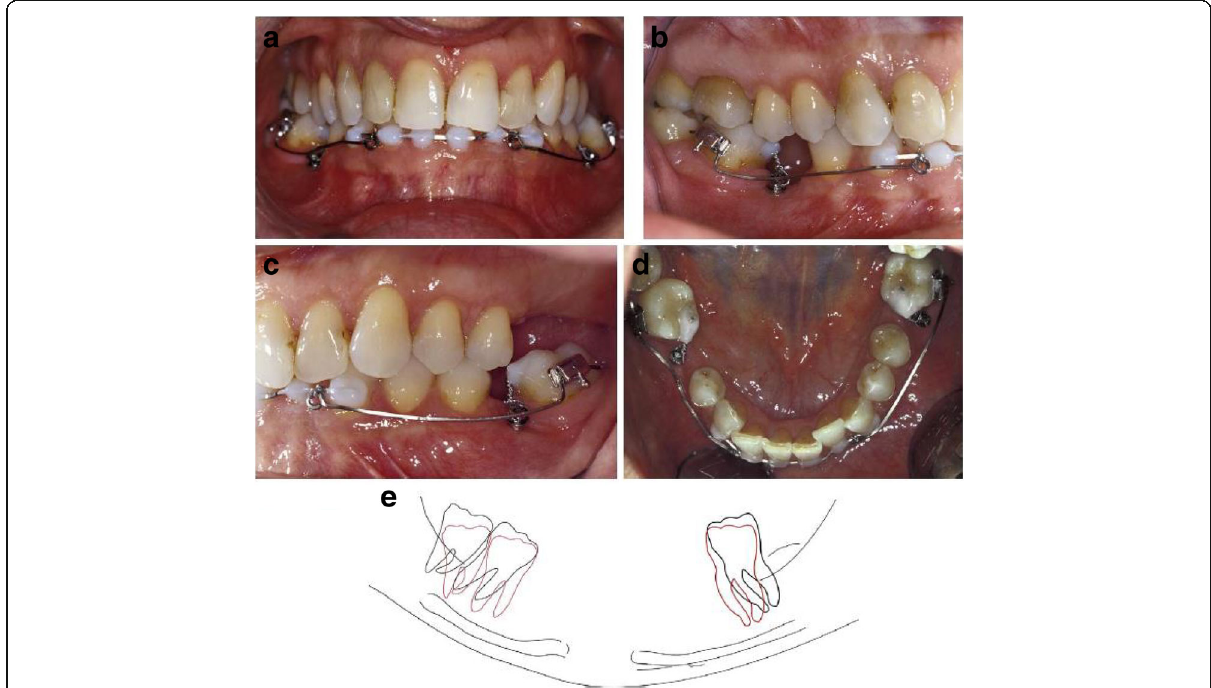
Fig. 11 Uprighting of mesially tipped #37 and #46 with miniscrew implant and long cantilevers. The cantilevers generate molar uprighting, molar extrusion, and intrusion of the anterior teeth. Ligature between miniscrew and molar is used to control the extrusive force and the distal crown movement of each molar. Thus, the uprighting is mainly achieved by mesial root tipping. a The beginning of uprighting of #37 and #46 with long cantilevers, from the molar to the anterior teeth, and a screw mesial to the molar. b Lateral view at the initiation stage of uprighting of #46. c Lateral view at the initiation stage of uprighting of #37. d Occlusal view during the beginning stage of uprighting of #37 and #46. e Lateral view tracing of uprighting of #37 and #46 with superimposition. The black line stands for the initial position and the red line for the final position. The superimposition is applied on the panoramic radiograph and the mandibular canal the external oblique ridge and the lower border of the mandible are chosen as reference points (from Musilli et al. [2], with kind permission of Progress in